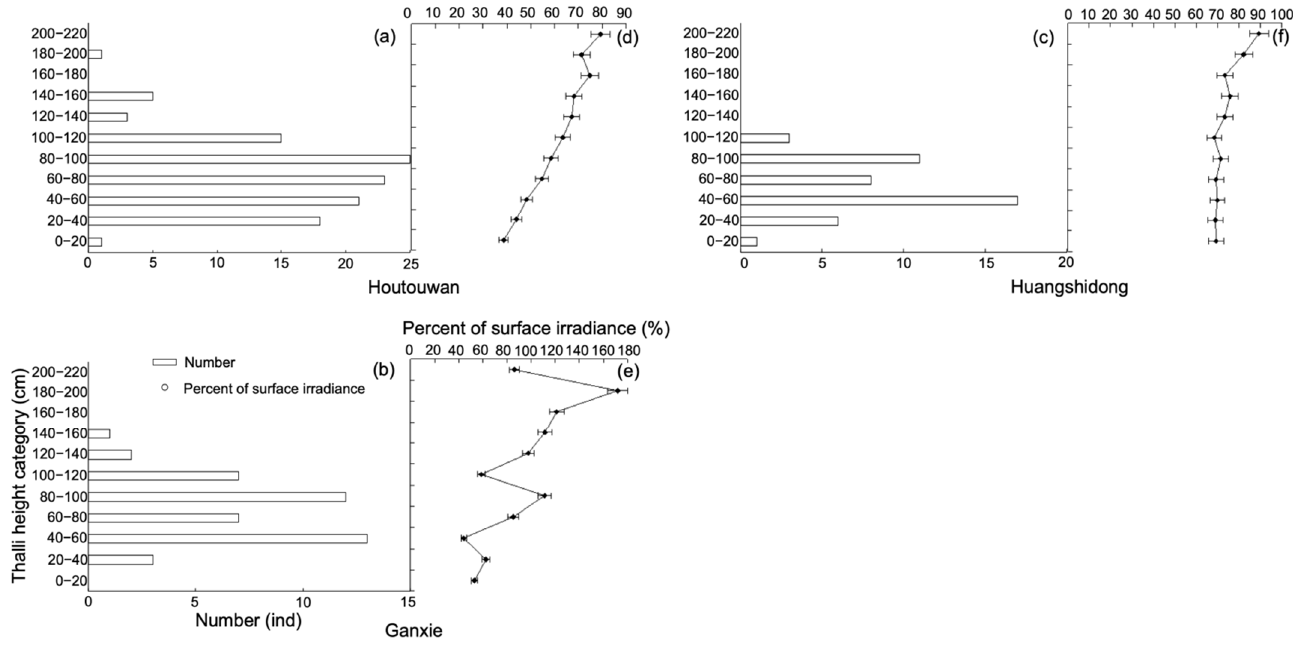
Figure 4. Relationships between thalli height category of Sargassum horneri from 0–20 cm to 200–220 cm in 20 cm height interval and the percent of surface irradiance (%) on June 10 in 2010 in Houtouwan (HTW), Huangshidong (HSD), and Ganxie (GX). The symbol ( a – c ) indicate the relationships between thalli height category (unit: cm) and thalli number (unit: ind); the symbol ( d – f ) indicate the relationships between thalli height category (unit: cm) and percent of surface irradiance (unit: %).